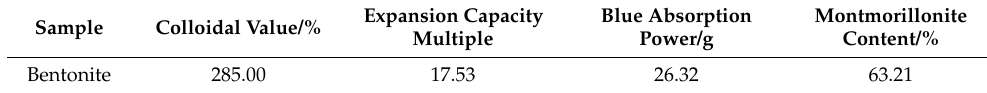
Table 2. Physical properties of bentonite.